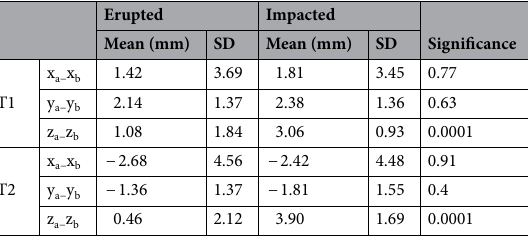
Erupted Impacted